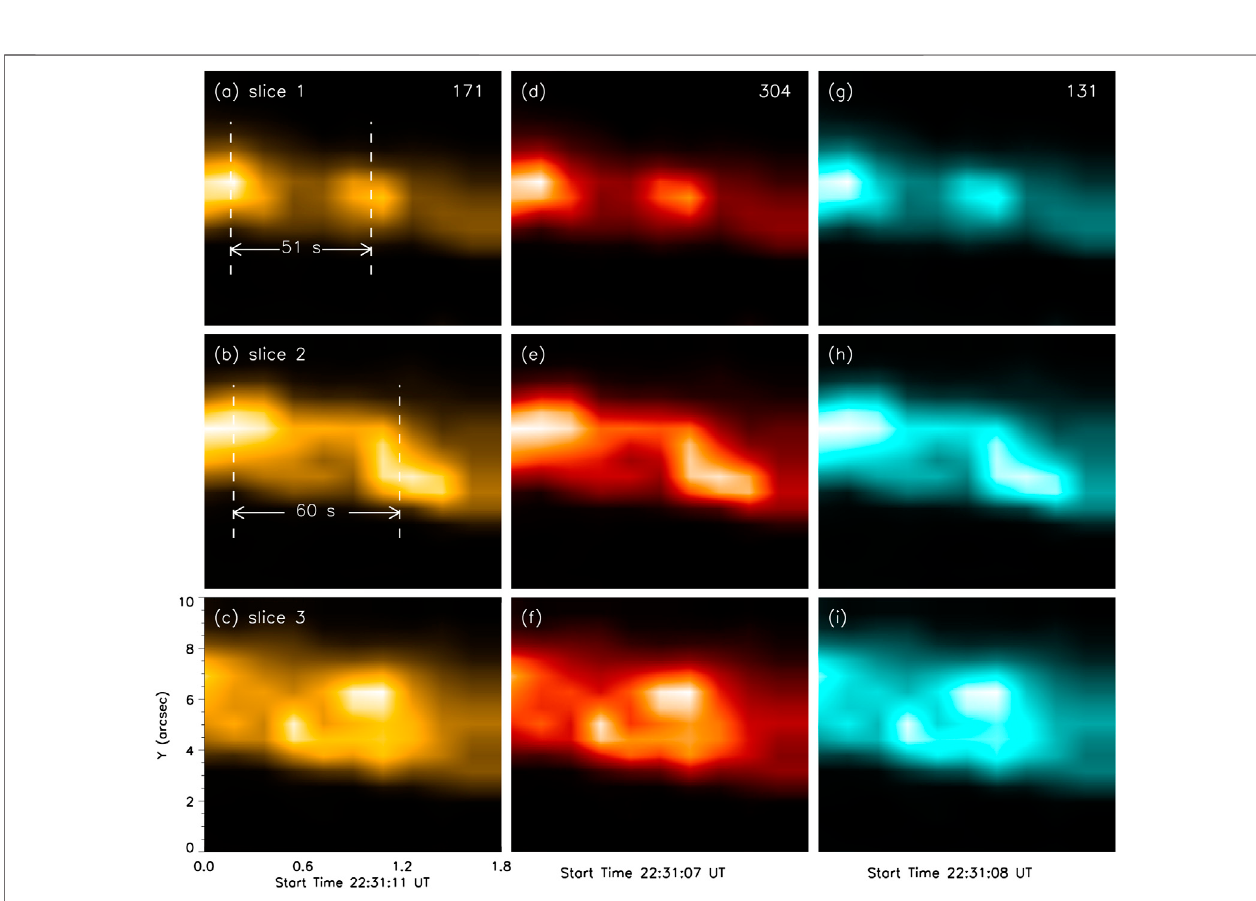
FIGURE 12 | Time-distance images of the blobs along the white dashed lines, i.e., perpendicular to the axis of the jet, as shown in Figure 9B at three different wavelengths: 171 Å, 304 Å and 131 Å.